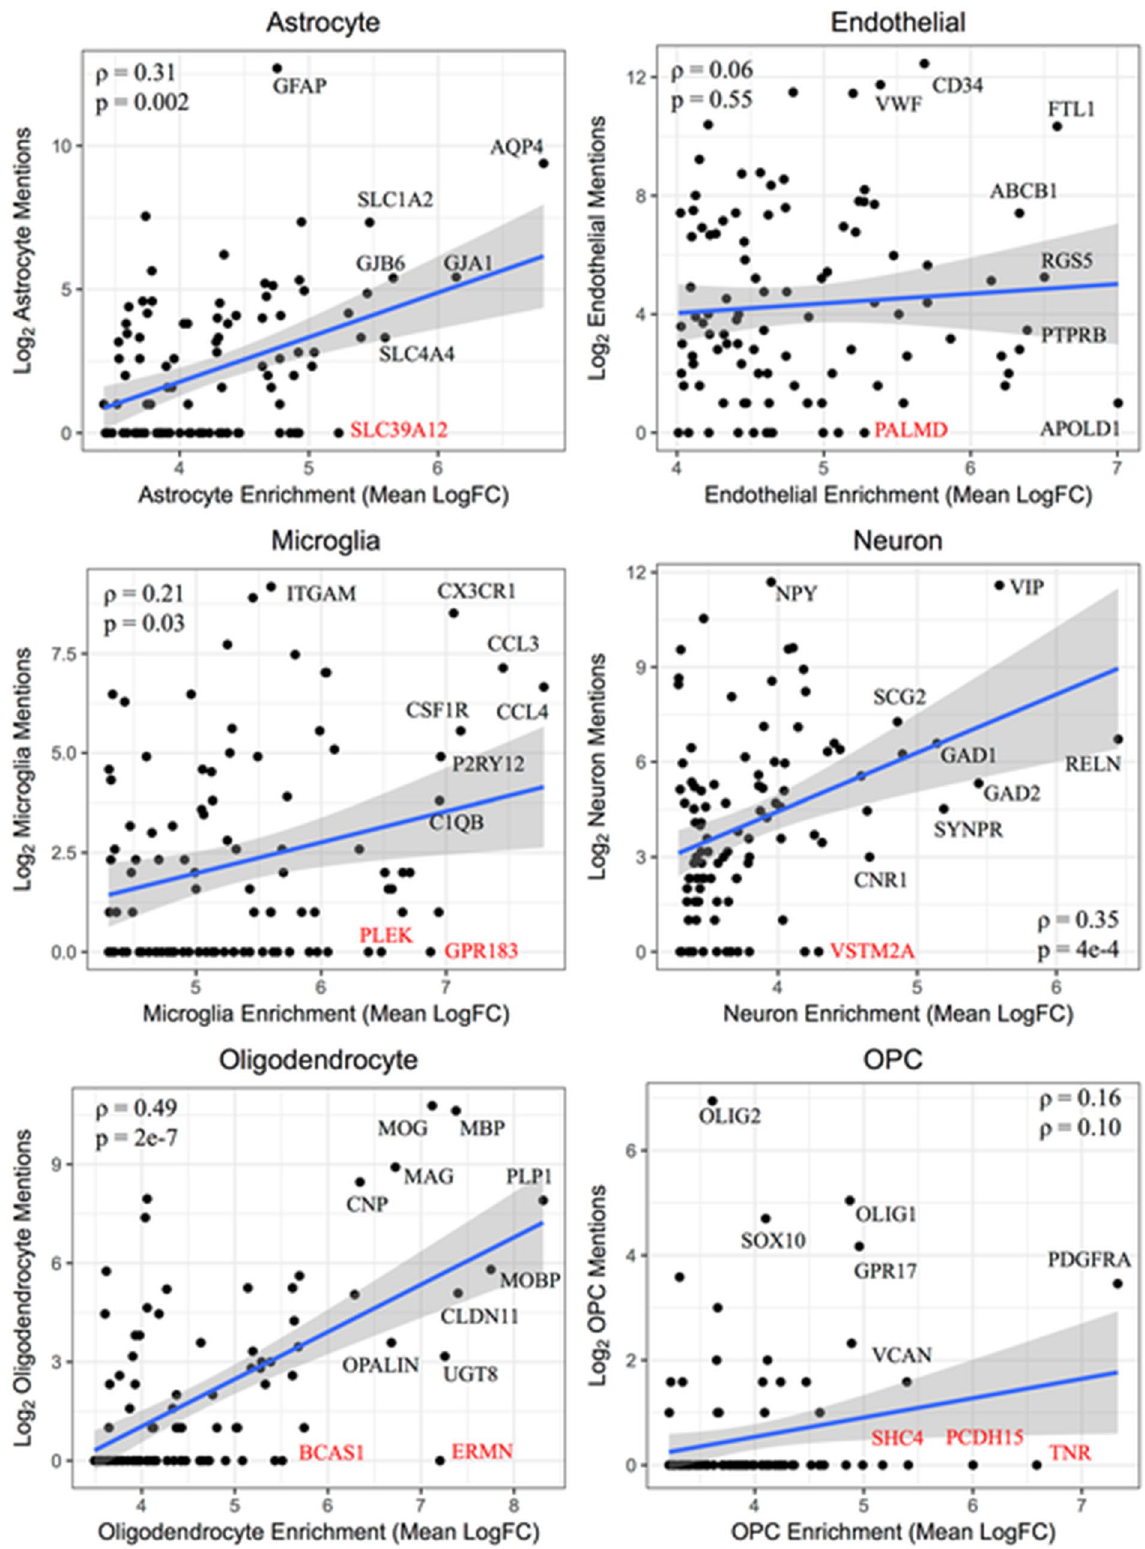
Figure 5. Intersections among the top genes for three cell type associated measures consensus rankings across all cell types. The top 100 genes ranked across both mouse and human data sets for each of the cell type measures are intersected using approximately proportional Venn diagrams for each of the astrocyte ( a ), endothelial cell ( b ), microglia ( c ), neuron ( d ), oligodendrocyte ( e ), and oligodendrocyte precursor cell ( f ) signatures. The Venn diagrams were generated using the R package Vennerable (version 3.0). The 5 genes with the top expression values in each of the cell types that intersect in all three of the top 100 gene sets are listed, with the exception of OPCs, for which all 7 of the genes with intersections between the three measures are